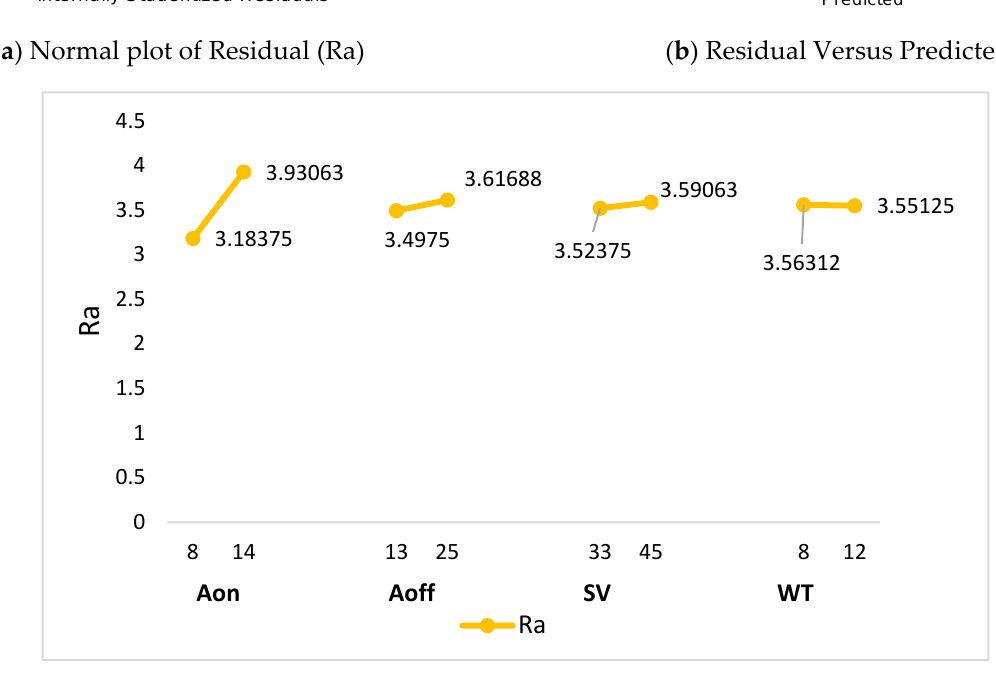
( c ) Variation of Ra with respect to Ra Figure 4. Summary of process parameters with respect to Ra. Figure 4. Summary of process parameters with respect to